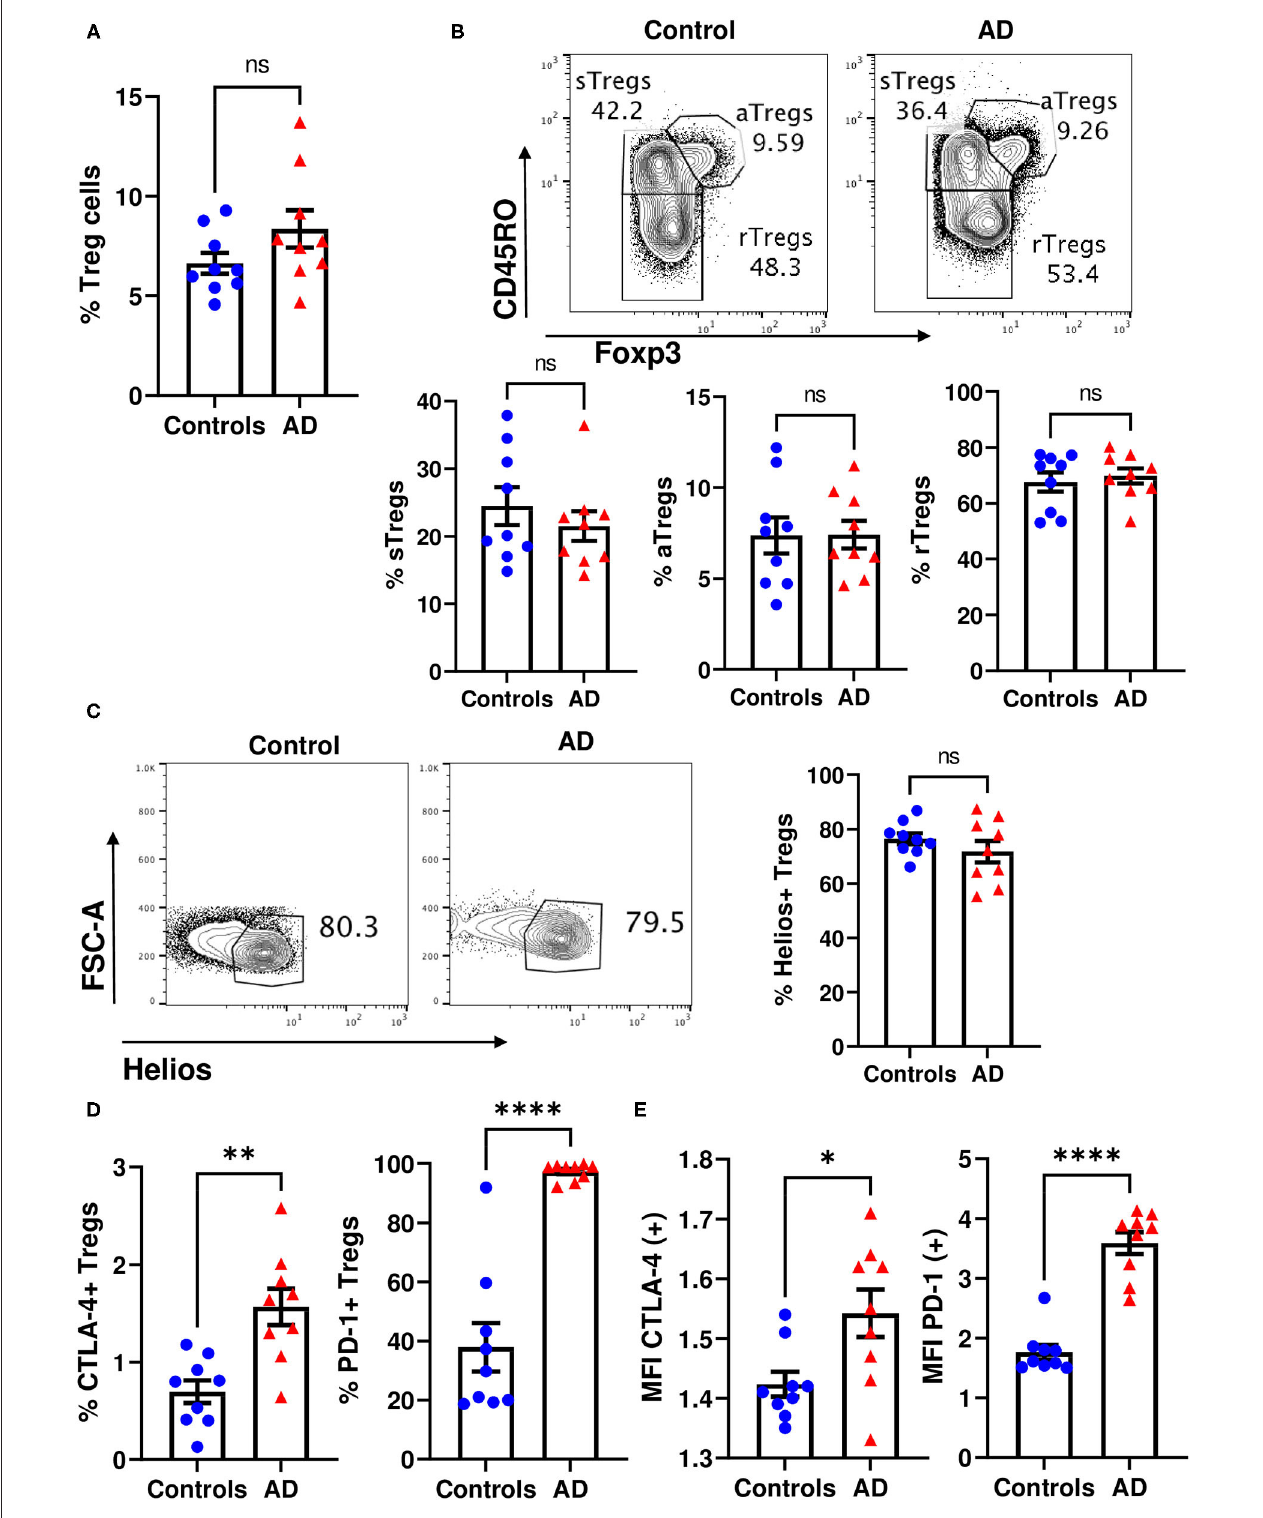
FIGURE 1 | Phenotypic characterization of Treg cells from moderate-to-severe AD children. (A) Dot-bar graphs showing the frequency of total Treg cells identified as CD4 + CD25highFoxP3 + cells in healthy control (blue dots) and moderate-to-severe AD (red triangles) children. (B) Representative contour plots showing